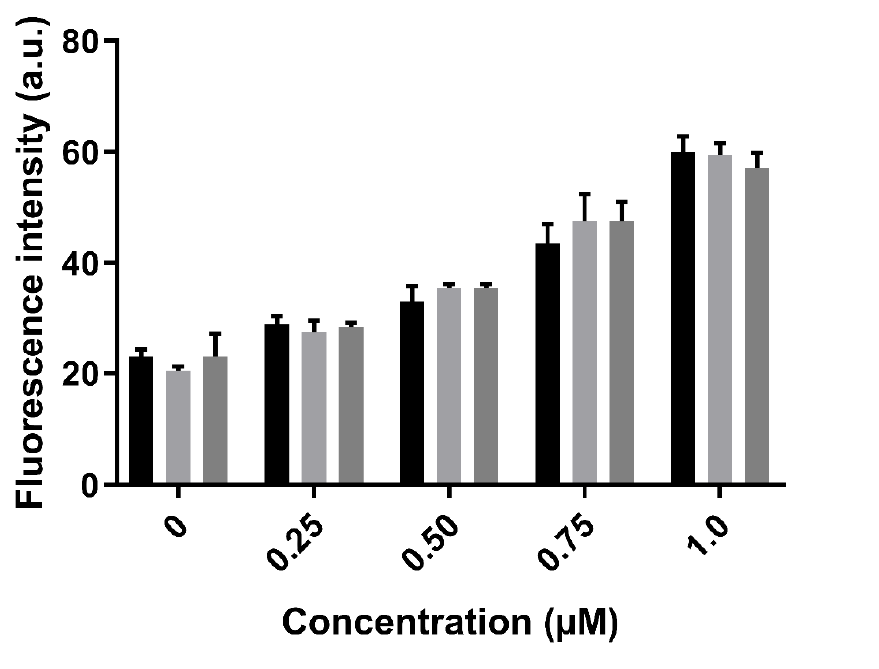
Figure 6. Fluorescence intensities (arbitrary unit; a.u.) of the cells in the presence of different CorA concentrations. The black bars represent the parental cells (MDCK II Parental), the light grey bars represent the cells with an overexpression of P-gp (MDCK II MDR1) and the dark grey bars represent the cells with an overexpression of BCRP (MDCK II BCRP) (mean ± SD, n = 3).